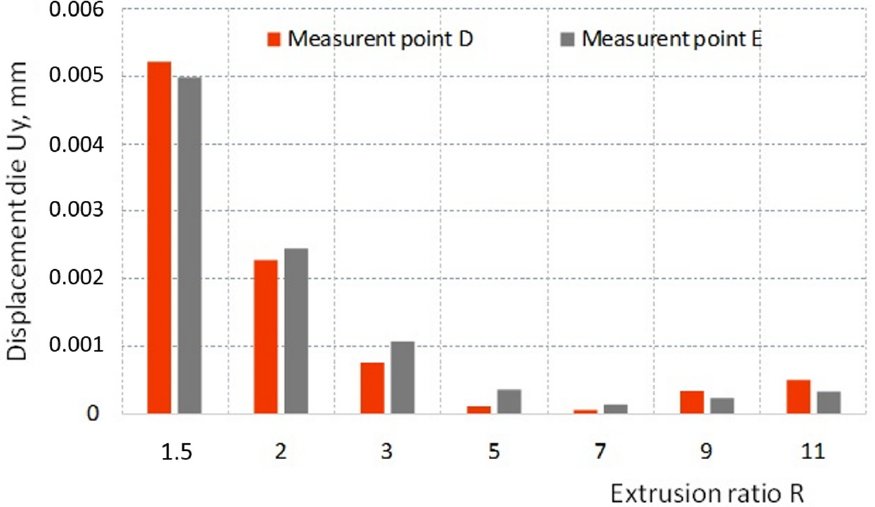
Figure 10. The impact of extrusion ratio R on the radial displacement Uy of the die at points D and E.